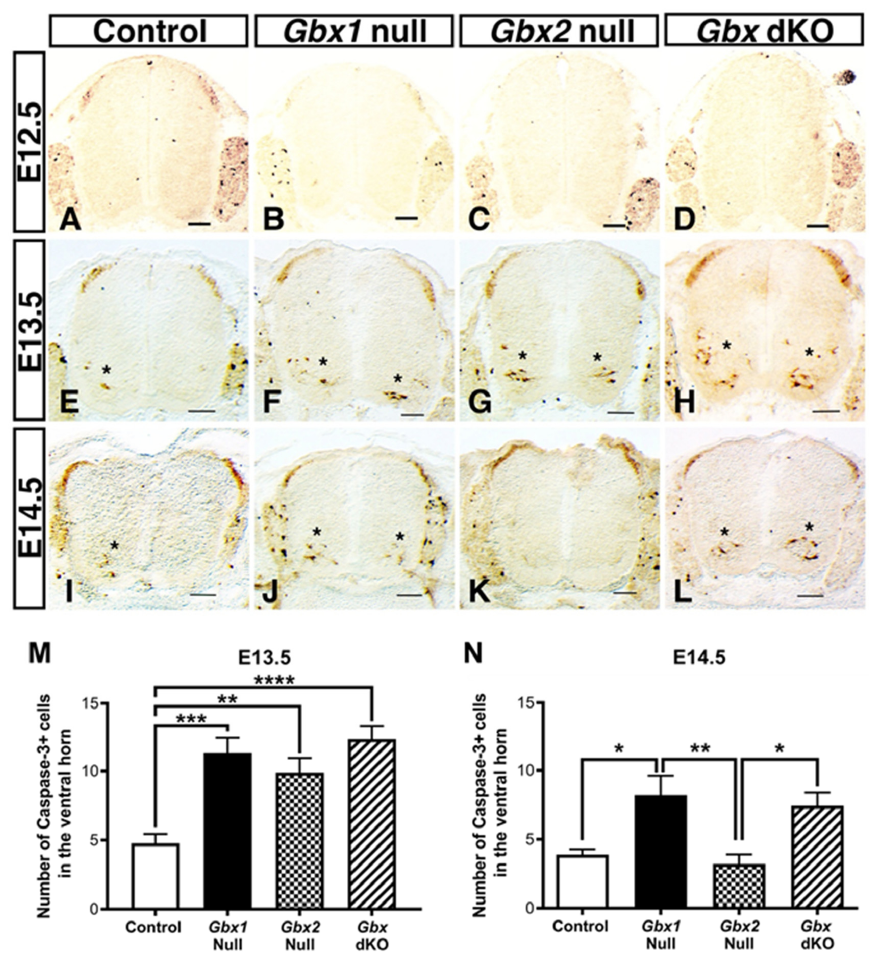
Figure 4. Deletion of Gbx genes results in apoptosis of neurons in the ventral spinal cord. Immunostaining of E12.5 ( A – D ), E13.5 ( E – H ), and E14.5 ( I – L ) lumbar spinal cords to detect